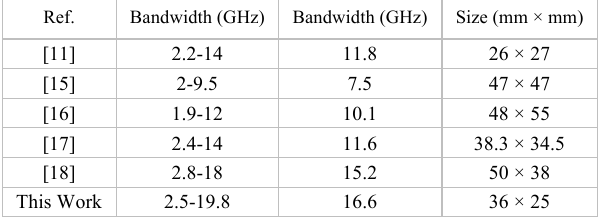
FIGURE 12. Simulated and measured peak gains of the proposed UWB antenna.